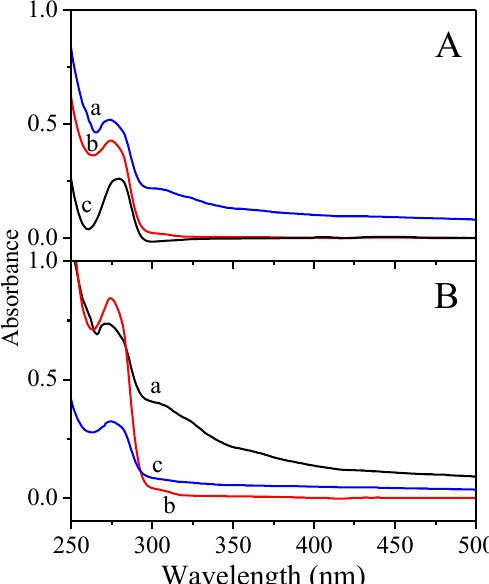
Figure 5. UV-VIS spectrum of pure PVC and PVC stabilized with different thermal stabilities heated for 0 min ( A ) and 60 min ( B ) at 180 °C. a: Pure PVC; b: CaSt 2 /ZnSt 2 ; c: DMAE-Zn.